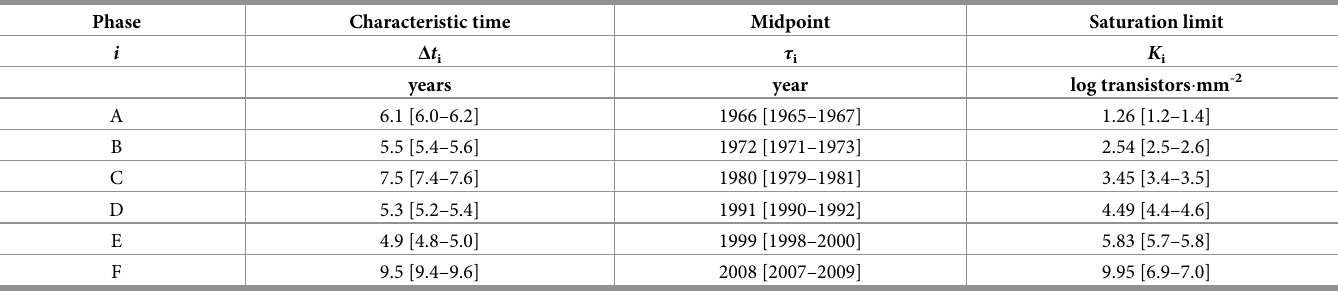
Table 3. Bi-logistic parameter